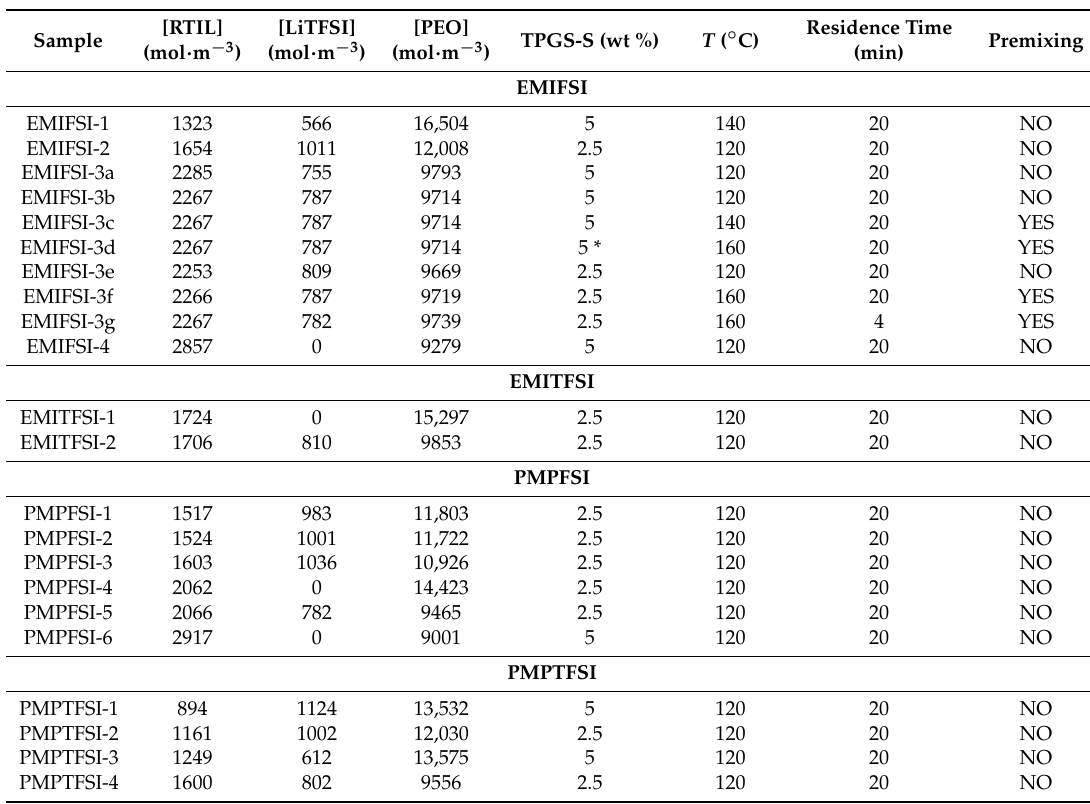
Table 1. Composition and processing conditions (extrusion, temperature, residence time, and premixing stage) of the